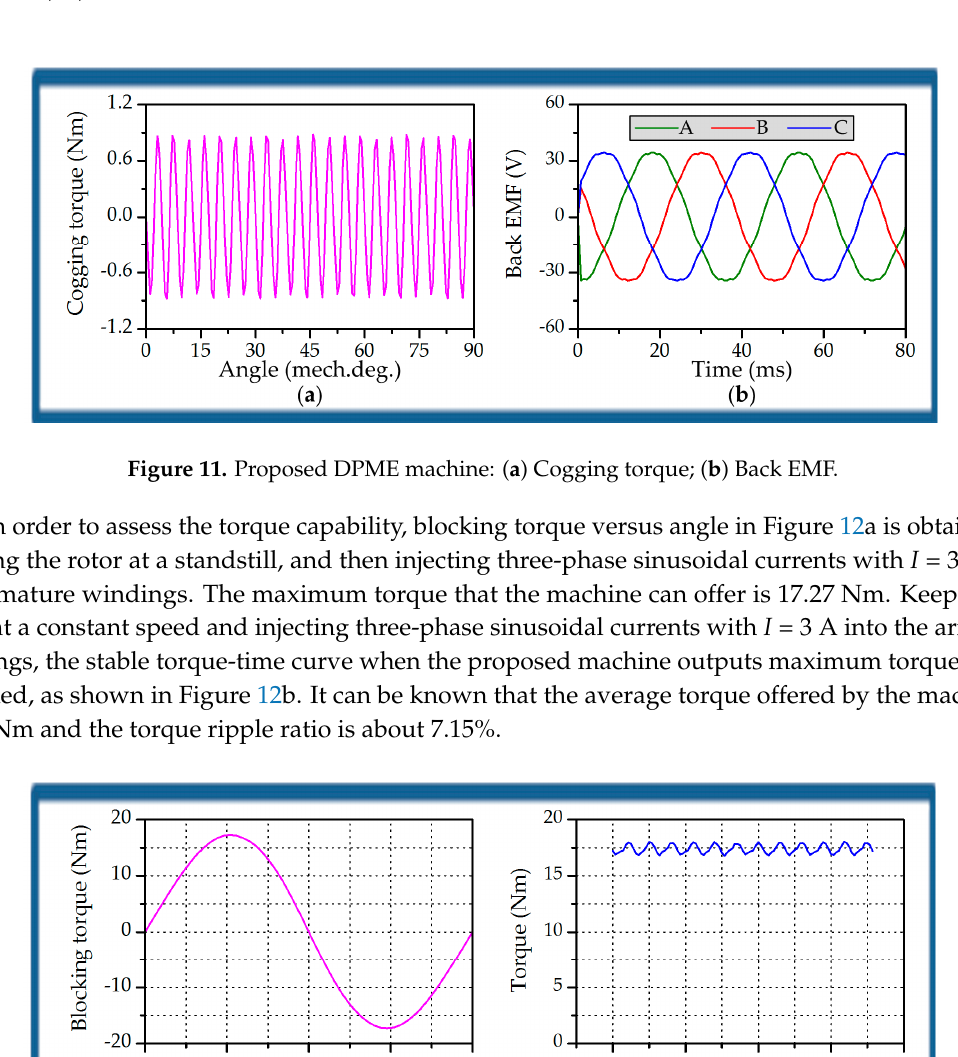
Figure 10. Air-gap relative permeability due to stator iron teeth: ( a ) Waveforms of relative permeability; and, ( b ) Corresponding harmonic spectrum.